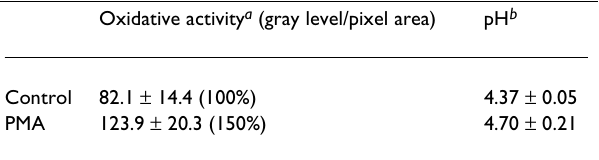
Table 1: Effect of PMA on the oxidative activity and pH of total lysosomes Oxidative activity a (gray level/pixel area)